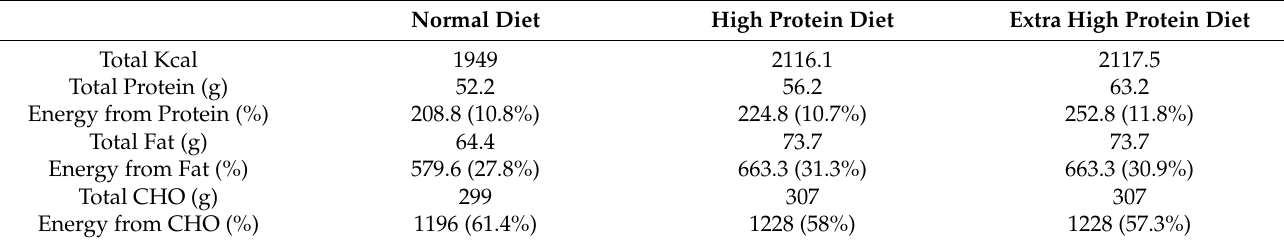
Table 8. Nutritional composition of the different diets at